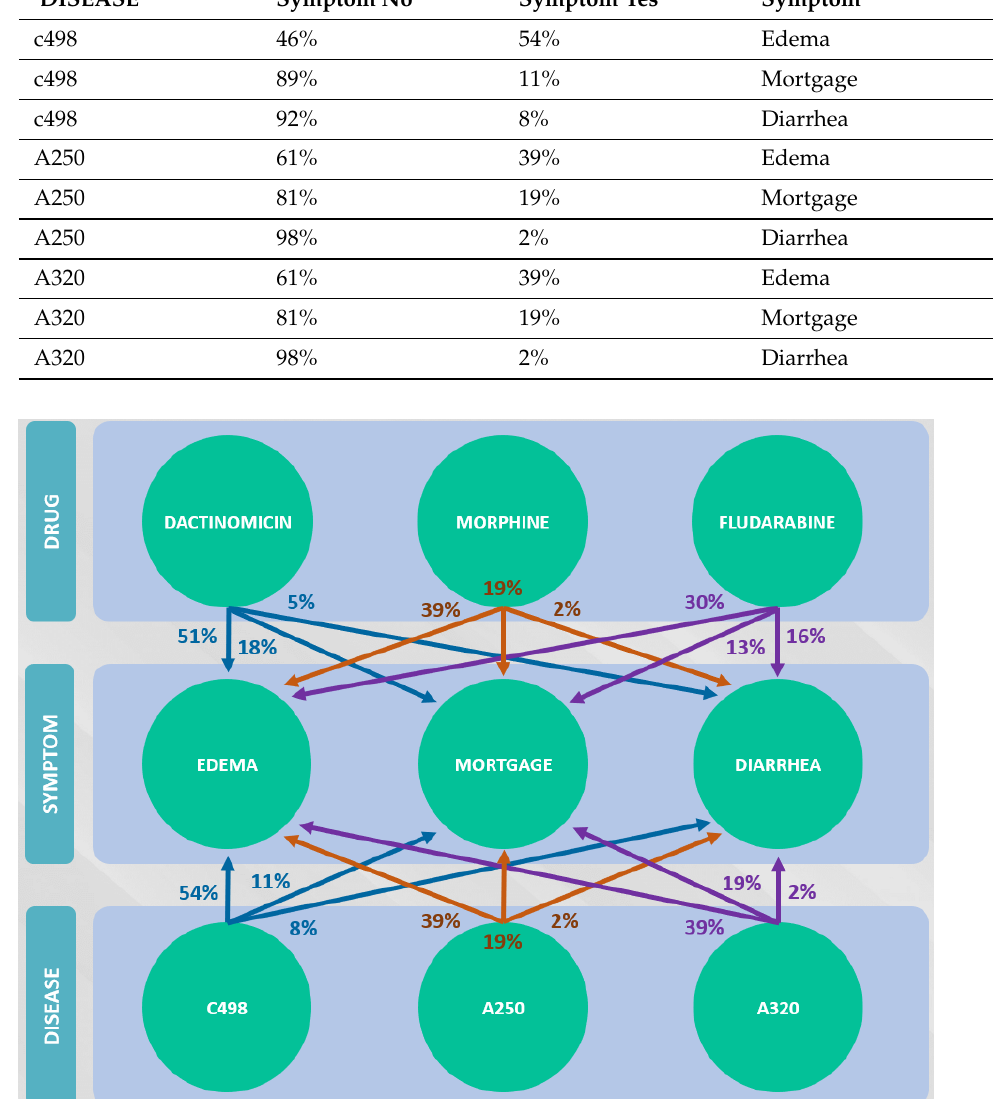
Figure 7. Bayesian